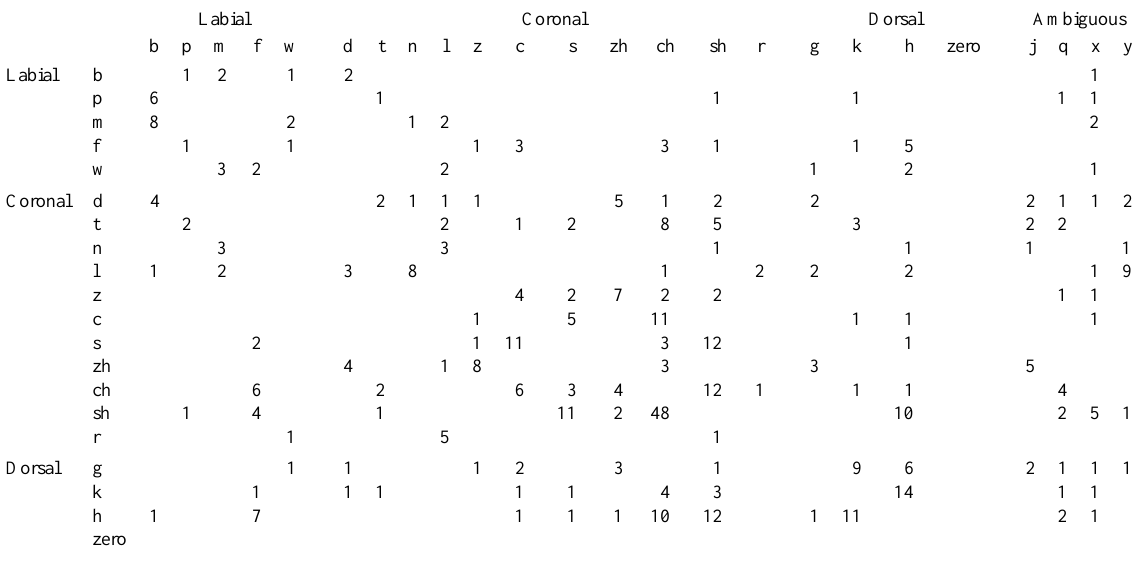
Table 5 Matrix of onset substitution errors in oral production tasks (the target onsets by rows and the response onsets by columns) Labial Coronal